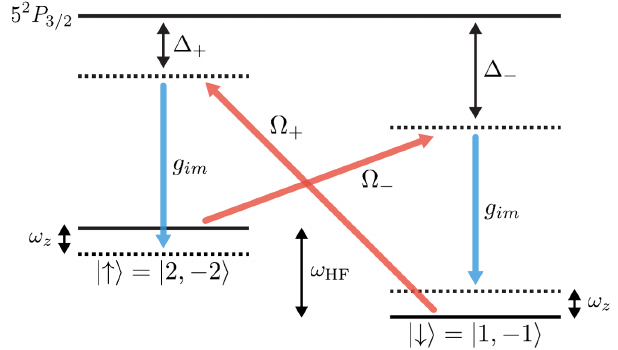
FIG. 2. Double Raman atomic coupling. The scheme provides a two-level system, corresponding to the two hyperfine states of 87 Rb. Two transversely oriented pump beams are used to generate cavity-assisted two-photon processes coupling the states j F; m F i ¼ j 2 ; − 2 i ≡ j ↑ i and j F; m F i ¼ j 1 ; − 1 i ≡ j ↓ i